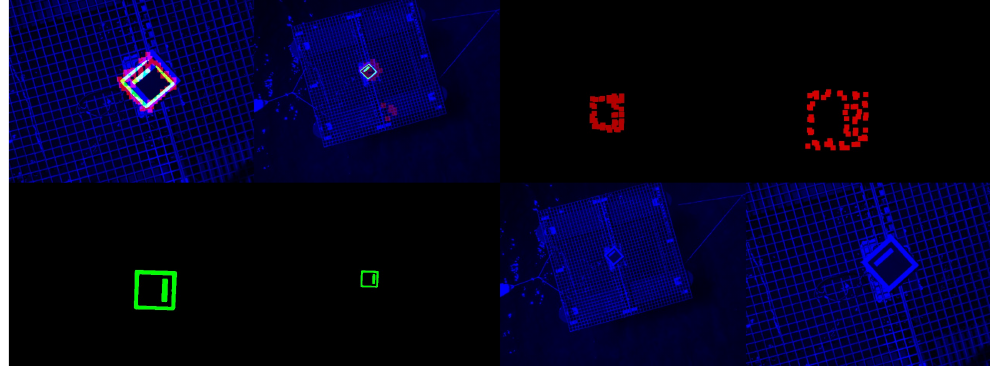
Figure 10. Samples from the Early Fusion dataset.